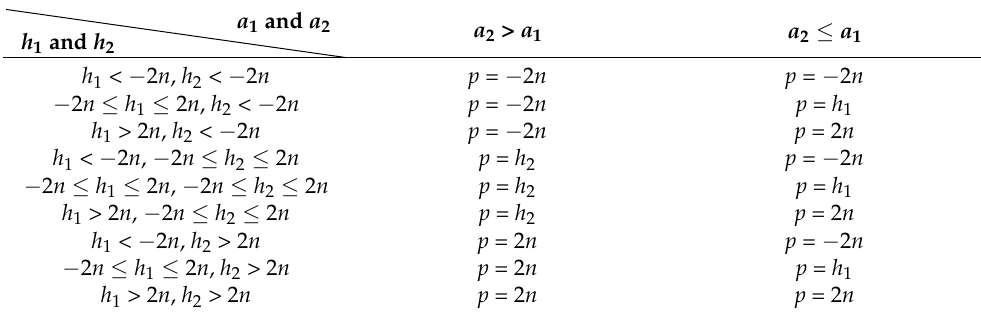
Table 2. The abscissa of the minimum of J ( h ) in [ − 2 n , 2 n ]. a 1 and a 2 h 1 and h